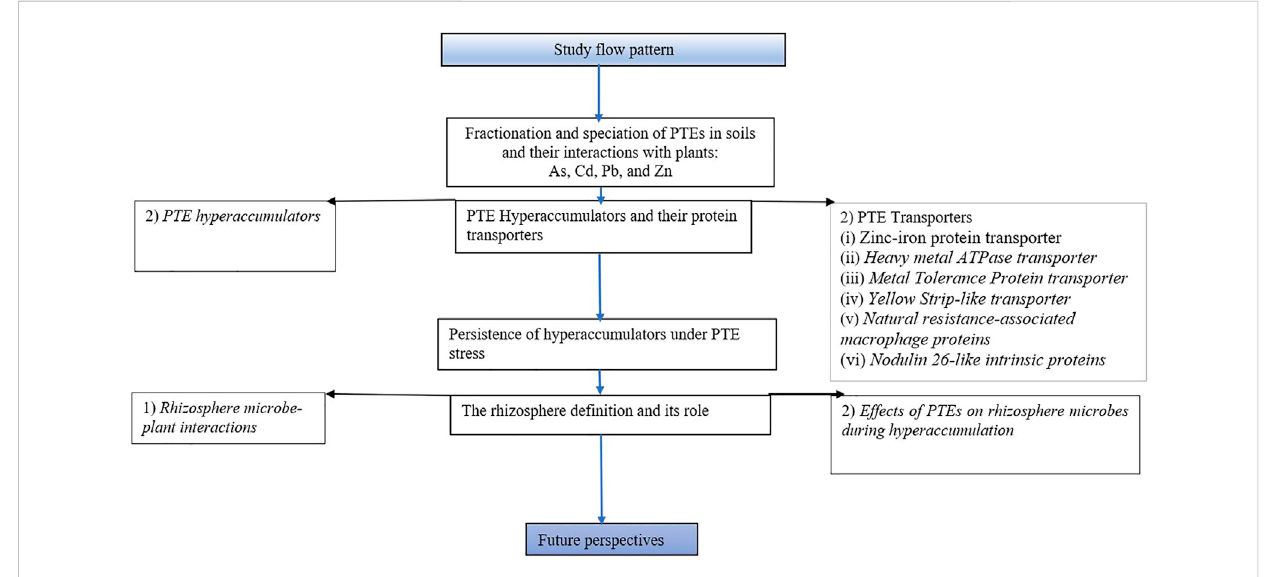
FIGURE 2 Showing the sequential fl ow of topical issues treated in this